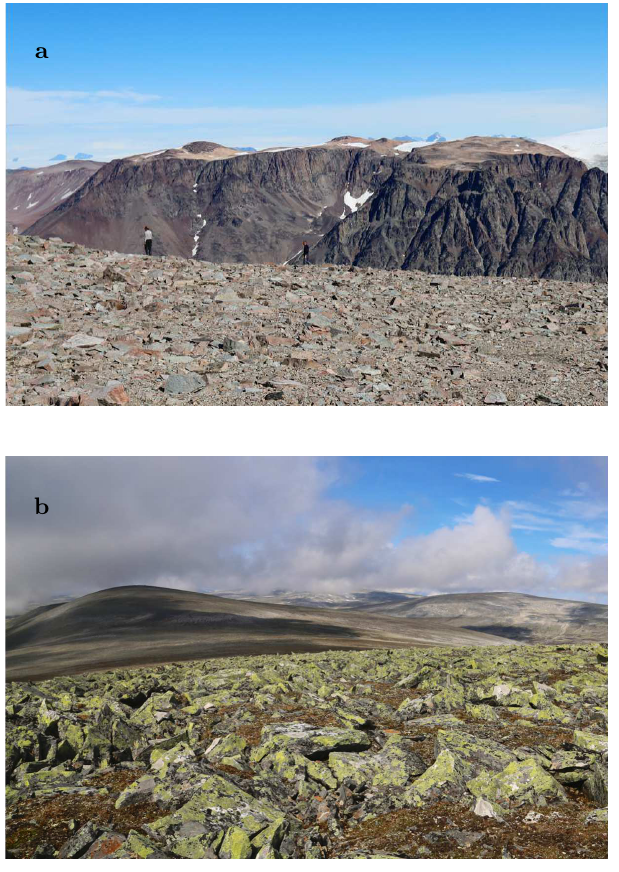
Figure 1. Examples of high-elevation, low-relief mountain land- scapes. Panel (a) : summit flats bounded by glacial troughs in south Greenland (altitude 1660ma.s.l.). Panel (b) : smooth and convex summits in Reinheimen, south Norway (altitude 1770ma.s.l.). Both types of landscapes are covered in blockfields underlain by fine- grained sediment. Photos: D. L.